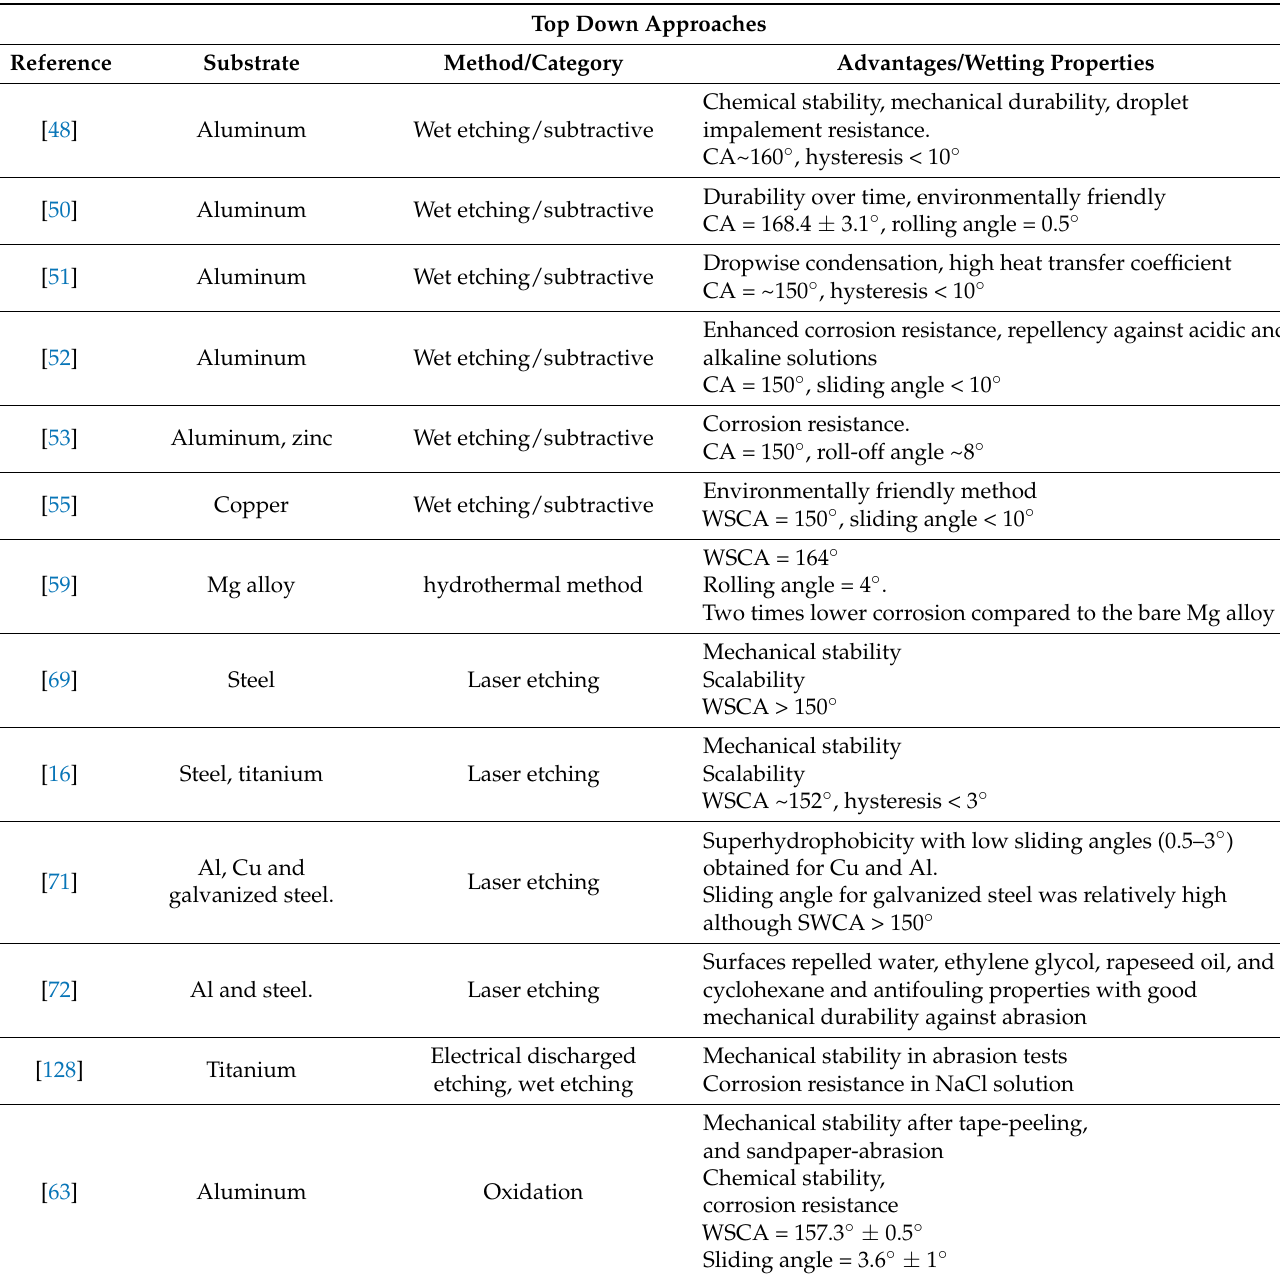
Table 1. Representative works on superhydrophobic metallic